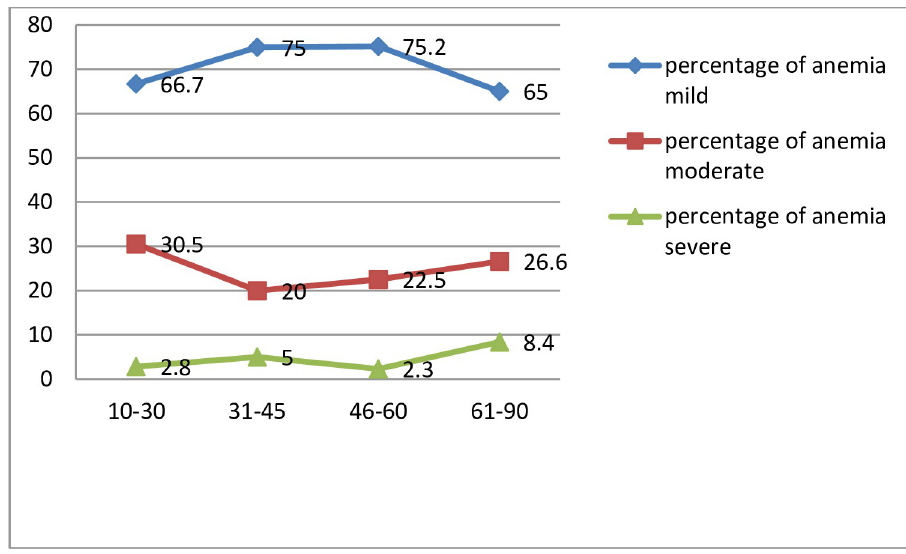
Fig 2. Prevalence of mild, moderate and severe anemia in percentage by age.